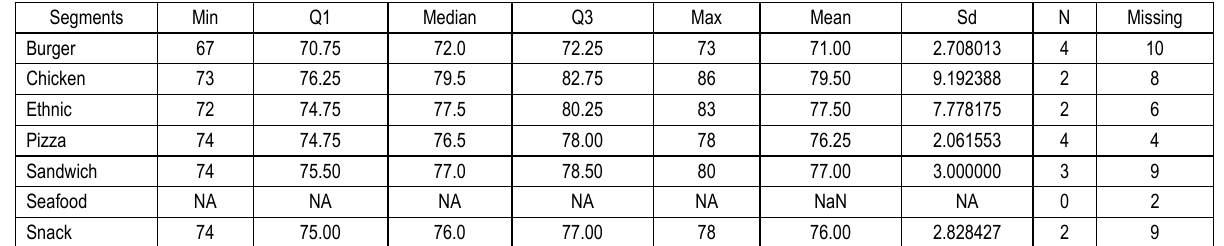
Table 4. Quick service restaurants ACSI index by